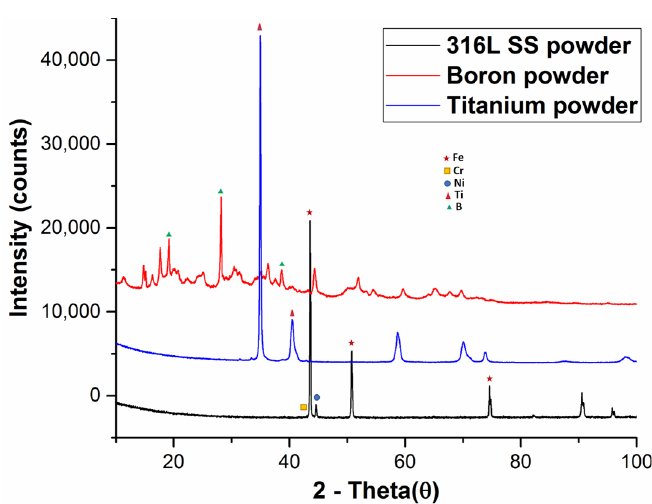
Figure 1. SEM images of ( a ) 316L SS, ( b ) boron, ( c ) titanium powder.